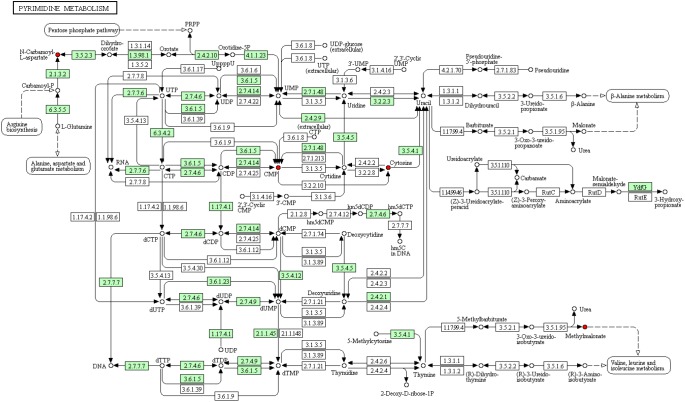
Pyrimidine metabolic pathways in mycelia after physiological maturation. Red cycle indicates up-regulated metabolite, arrow indicates reacted direction. Small green box represents the enzyme specific to the species. Dotted line indicates relationships with other metabolic pathways. Big cycle box represents other metabolic pathways.